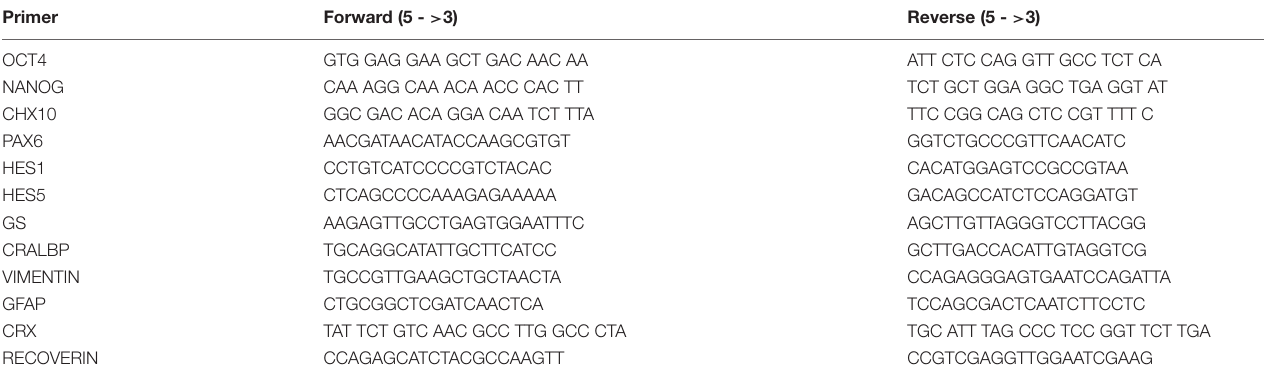
TABLE 1 | Primers used in this